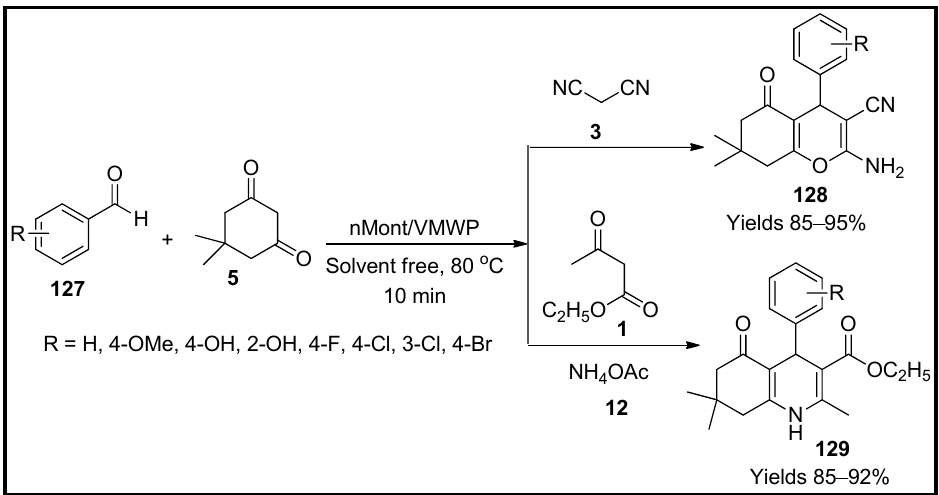
Scheme 44. Pyran derivatives synthesised by nMont/VMWP catalyst.